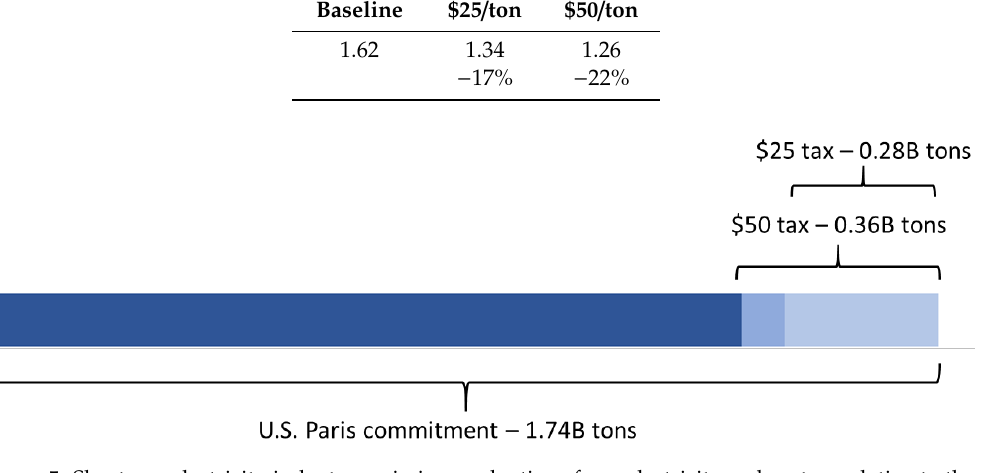
Figure 5. Short run electricity industry emissions reductions from electricity carbon tax, relative to the total U.S. commitment for the Paris Climate Accord.